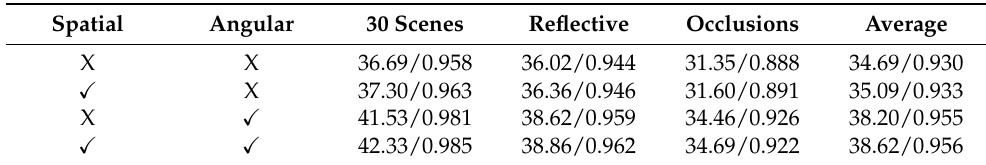
blocks, where (cid:88) means this augmentation block while X not using it. We observe the best PSNR (dB) and SSIM values on three real-world LF datasets.